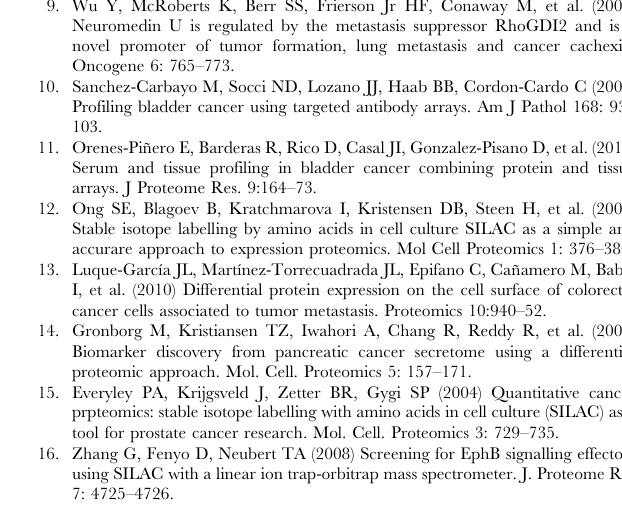
Figure S3 Functional networks of the proteins identi- fied: in silico protein interaction analysis. Molecular network obtained using the IPA software selected from the networks of differentially expressed proteins identified as it contained the highest number of the proteins identified by SILAC (n =31). Addition of Cul3, the validated candidate, to this molecular network served to generate an interaction map connecting the novel candidate with other proteins identified through their previously described biological interactions. In this network, genes or gene products are represented as nodes, and the biological relationship between two nodes is represented as an edge. All edges are supported by at least one publication from the information stored in the Ingenuity knowledge database. Figure S4 Functional networks of the proteins identi- fied: in silico protein interaction analysis. Biological interaction networking highlighted on the map of the top ten differentially expressed proteins in SILAC and oligonucleotide arrays, and validated in Western blots, including Cul3. Accession number and T24T/T24 ratio values for the proteins identified in Table 1 were imported into IPA software to generate different molecular networks. In this network, genes or gene products are represented as nodes, and the biological relationship between two nodes is represented as an edge. All edges are supported by at least one publication from the information stored in the Ingenuity knowledge database. The intensity of the node colour indicates the degree of over- (red) or under- (green) expression in T24T when compared to T24. The legend of the interaction network and the relationships between molecules is also provided. Table S1 Proteins with altered abundance in bladder cancer metastatic cells. All proteins were identified at . 99% confidence (corresponding to a Mascot score . 46). The table includes accession number (gi), protein name, molecular weight (in kD), gene array ratio, SILAC ratios and the standard deviation (SD, n= 2). All proteins were identified in the two SILAC